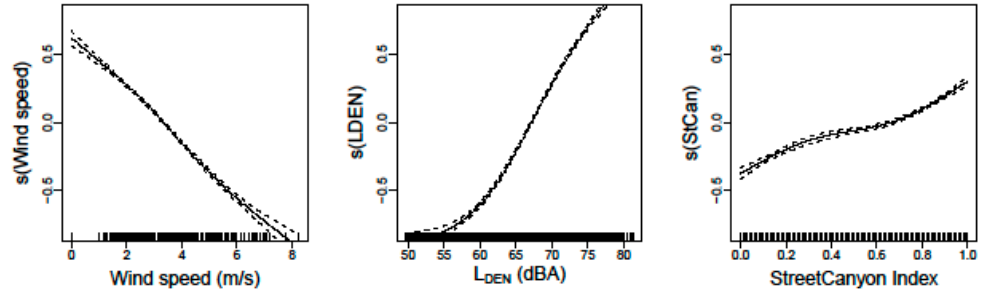
Figure 6. Splines of the extrapolated variant of the instantaneous bicyclist exposure model using a L DEN noise map as the underlying alternative traffic layer.